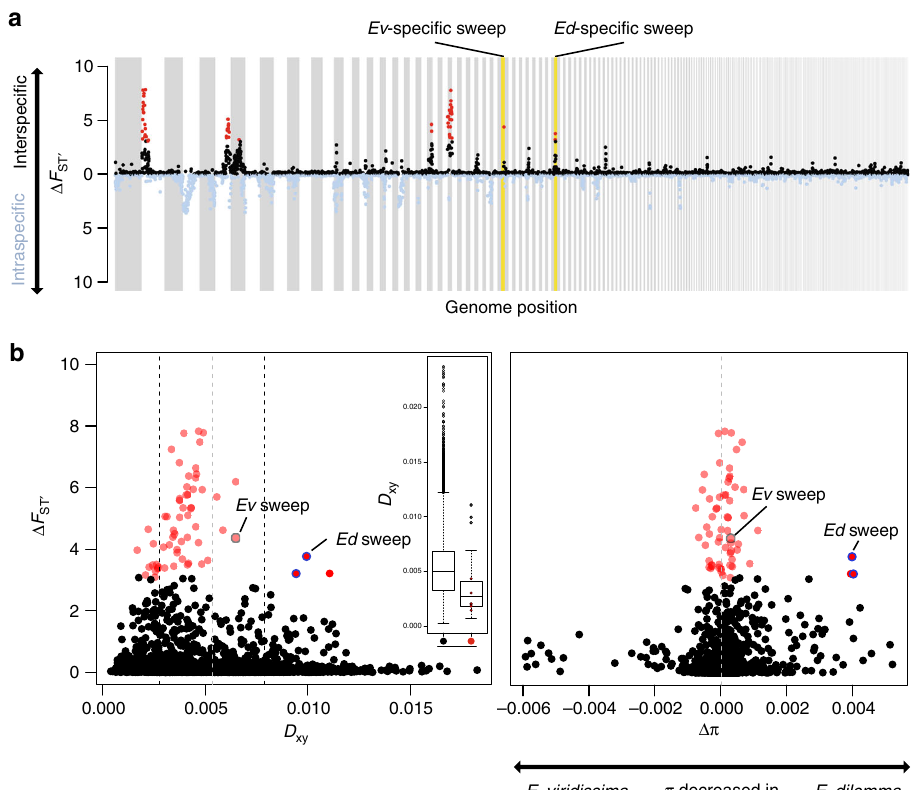
Fig. 2 Whole-genome differentiation. a Eight regions of the genome revealed higher interspeci fi c (black) than intraspeci fi c (blue) differentiation ( Δ F ST ’ > 99th percentile red). Outlier peaks with E. dilemma ( Ed ) and E. viridissima ( Ev )-speci fi c selective sweep signatures are highlighted in yellow. b Interspeci fi c divergence ( D xy ) was negatively correlated with Δ F ST ‘ (left panel, r = − 0.13, p = 0) and signi fi cantly reduced in outlier regions (red) in comparison with non-outliers (black, inlet, Mann – Whitney U -test, p = 0.001, mean D xy of all seven outlier regions overlaid in red). Only two of the three Δ F ST ‘ outlier windows (circled blue) that revealed increased D xy also had a net differential of intraspeci fi c nucleotide diversity ( Δ π = π Ev − π Ed ) skewed towards E. dilemma (right panel), a pattern expected in genomic regions evolving under positive selection. Both correspond to the same outlier peak (rightmost of those with yellow background in a ). Gray dashed lines: mean D xy and Δ π . Black dashed lines: 1 SEM D xy . Boxplot elements: center line represents the median, box bounds represent the 25th and 75th percentile, and whiskers represent the 25th percentile − 1.5 * the interquartile range and the 75th percentile + 1.5 * the interquartile